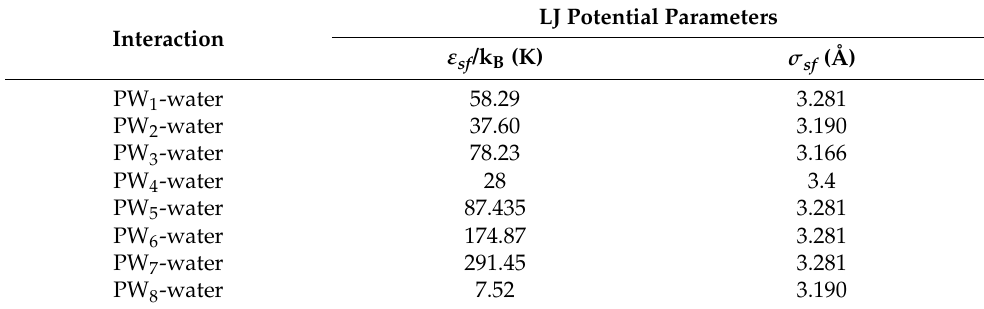
Table 1. Summary of LJ potential parameters of eight types of pore walls and